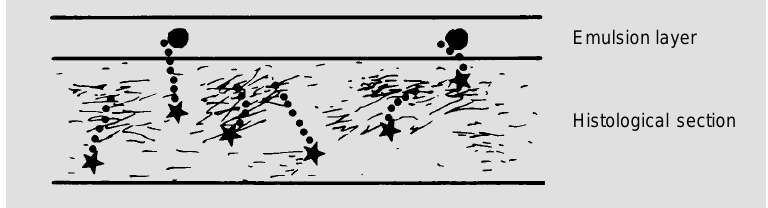
Figure 4 - Schematic illustration of an autoradiograph for demonstrating [ 3 H]-ß-self-absorp- tion. The stars represent decaying ß-isotopes, and the dots virtual